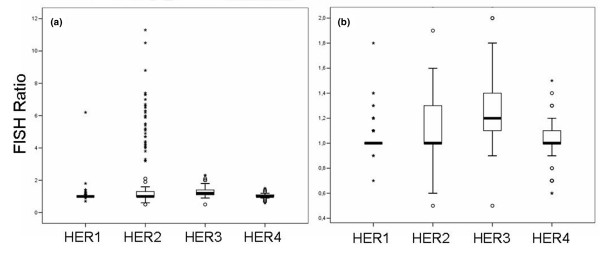
Distribution of HER1–4 FISH ratios. (a) Boxplots of HER1–HER4 FISH ratios (gene/centromere). (b) Magnified extract of (a) to demonstrate the different distribution pattern of ratios for each HER-family member.